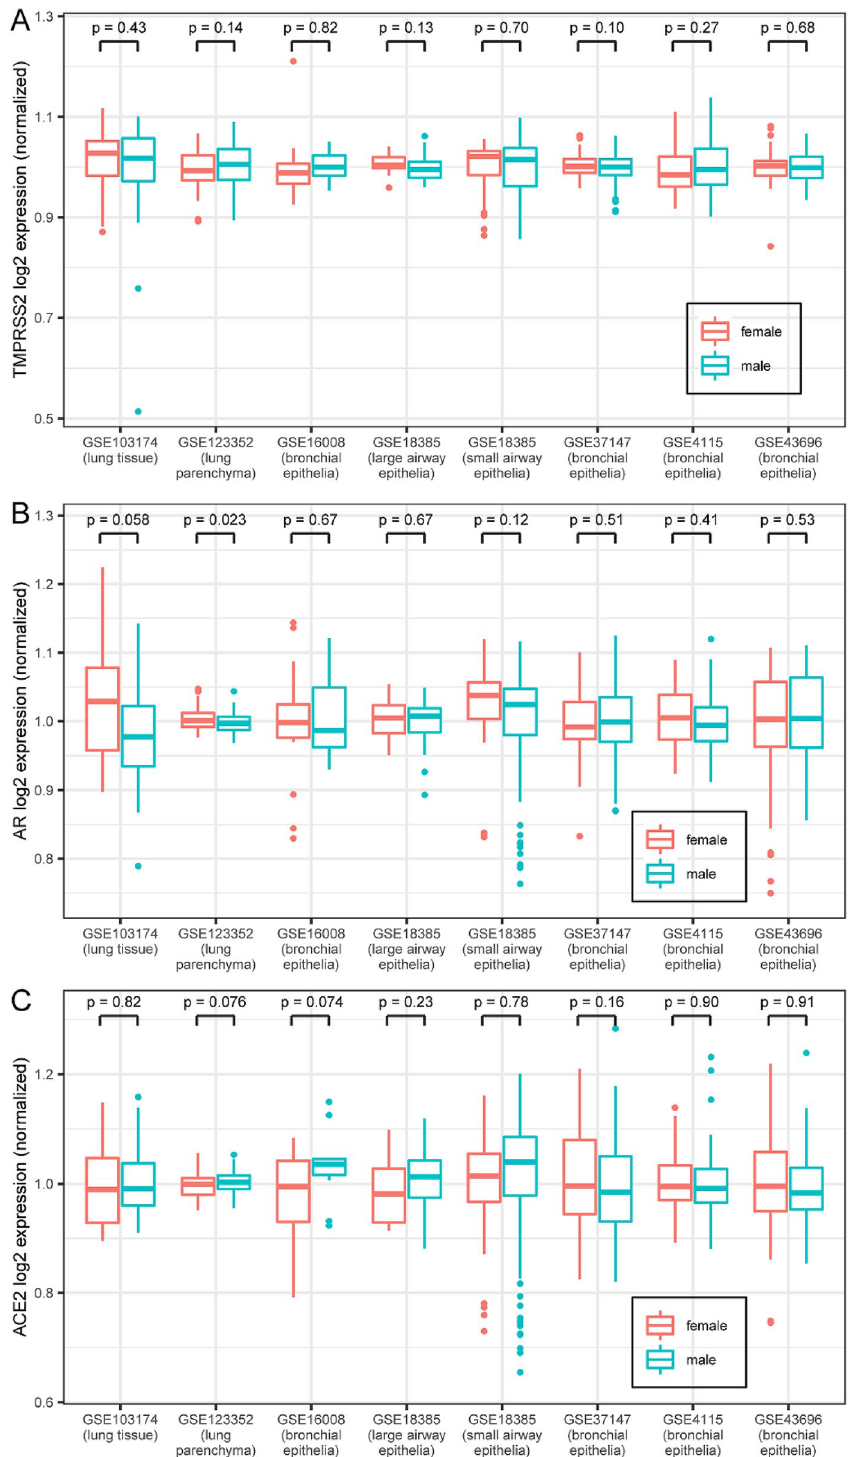
Figure 2. TMPRSS2, AR, and ACE2 transcript expression in human lung are similar in males and females. ( A ) Box plot of TMPRSS2 expression (normalized so that the mean within each data set equals 1) from the publicly available Gene Expression Omnibus (GEO) data sets. Center lines indicate median values, edges of boxes indicate first and third quartile values, whiskers indicate largest and smallest values extending no more than 1.5 * inter-quartile range from edges of boxes, and dots indicate outlier values. P-values from t-tests are shown for female vs. male comparison within each data set. N for each data set: GSE103174 = 22 female/31 male; GSE123352 = 81 female/95 male; GSE16008 = 15 female/11 male; GSE18385 large airway = 16 female/36 male; GSE18385 small airway = 35 female/74 male; GSE37147 = 103 female/135 male; GSE4115 = 41 female/122 male; GSE43696 = 74 female/34 male. Data sets 18,385 and 4115 contained multiple TMPRSS2 reference sequences; none of the individual sequences had female vs. male expression differences with p < 0.05, and the expression values of the different sequences were added together for this plot. ( B ) Box plot of AR expression from the same data sets as in ( A ). ( C ) Box plot of ACE2 expression from the same data sets as in ( A